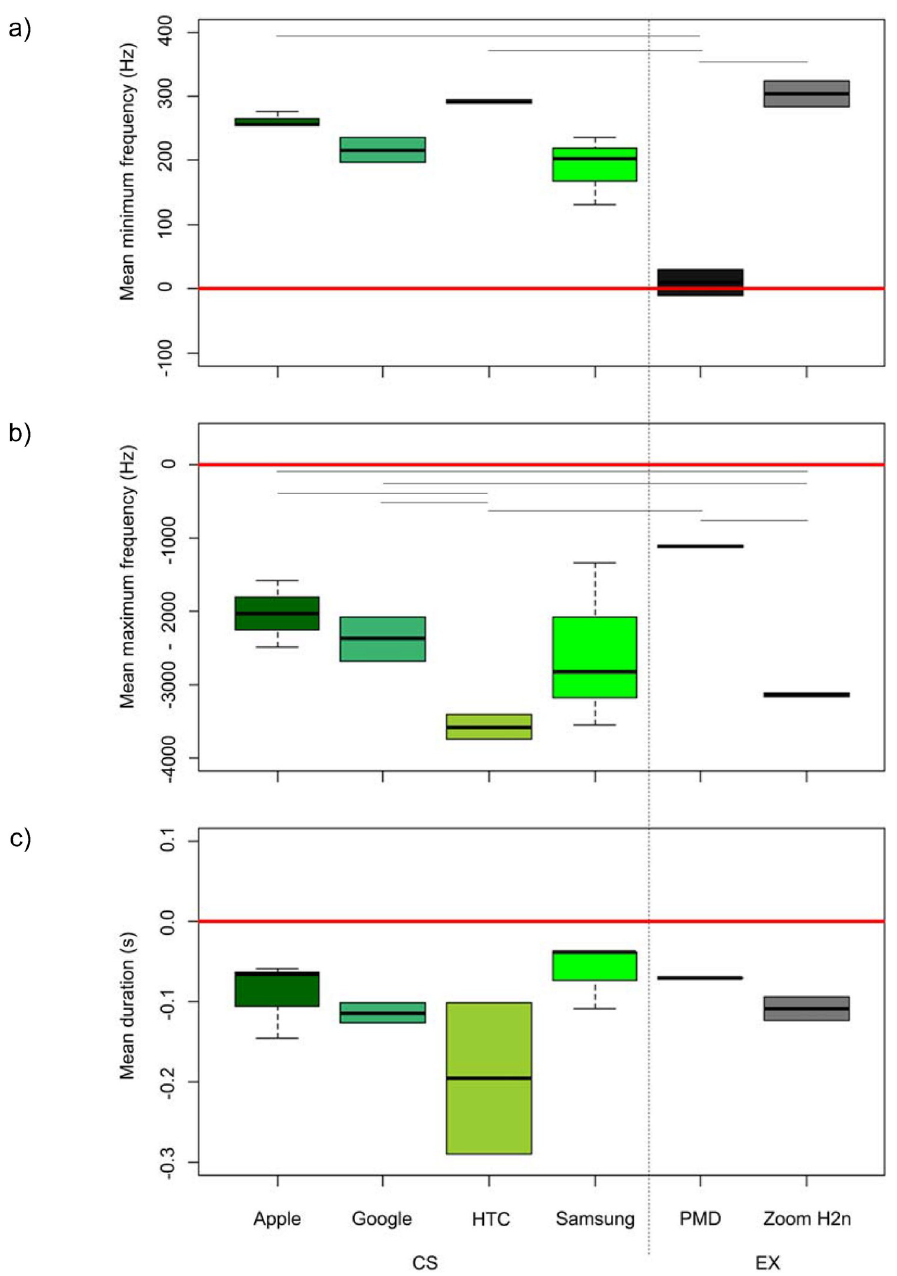
Fig 7. Comparison of deviations from original playback files of the different recording devices, i.e. smartphone brands (CS) and expert recordings equipment with professional microphones (EX) in a test. Depicted in boxplots is the deviation in a) the minimum frequency, b) the maximum frequency and c) song duration from playing back a test file of nightingale song. The median is represented by a solid black line within a box. The borders of boxes are 25 and 75 percentiles. The red line shows a zero line. The closer a deviation to the zero line is, the smaller it was. The black lines above boxplots indicate significant differences between the recording devices